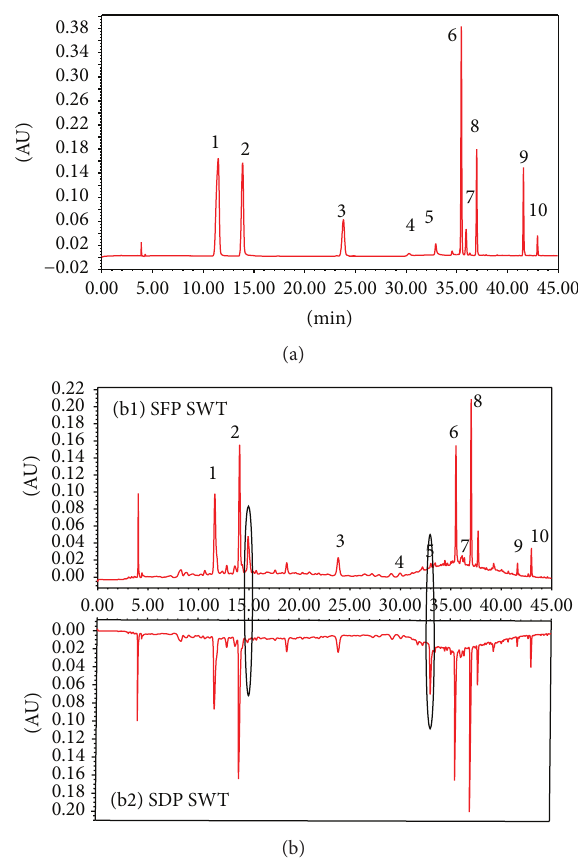
Figure 3: Typical HPLCchromatograms of mixed standard solution (a) and SWT sample solutions (b) ((b1) SFP SWT; (b2) SDP SWT). (1) Gallic acid, (2) 5-hydroxymethylfurfural, (3) cianidanol, (4) albiflorin, (5) paeoniflorin, (6) ferulic acid, (7) verbascoside, (8) senkyunolide I, (9) senkyunolide A, and (10) Z